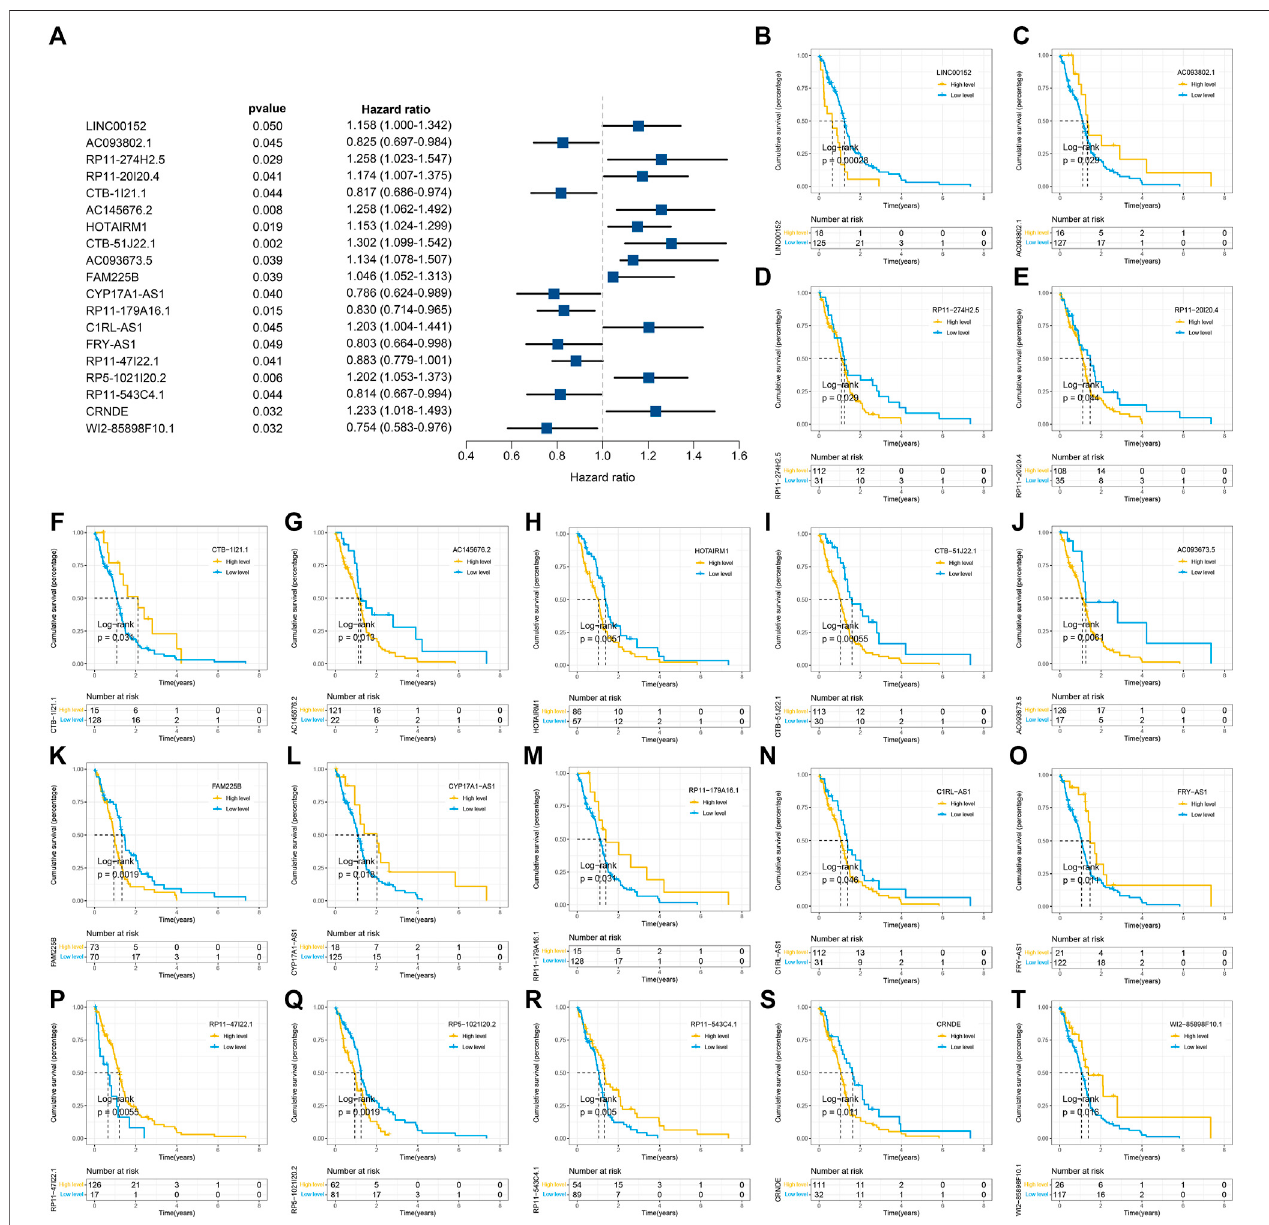
FIGURE 3 | Identi fi cation and of prognostic pyroptosis-related long noncoding RNAs (lncRNAs) and further Kaplan – Meier (KM) analysis. (A) Univariate Cox regression was utilized to identify 19 prognostic pyroptosis-related lncRNAs, and the corresponding p -values and hazard ratio values were also exhibited. (B – T) KM curves were illustrated to exhibit the relationship between overall survival (OS) and the expression levels of these 19 pyroptosis-related lncRNAs (PRLs) based on the optimal cutoff points.